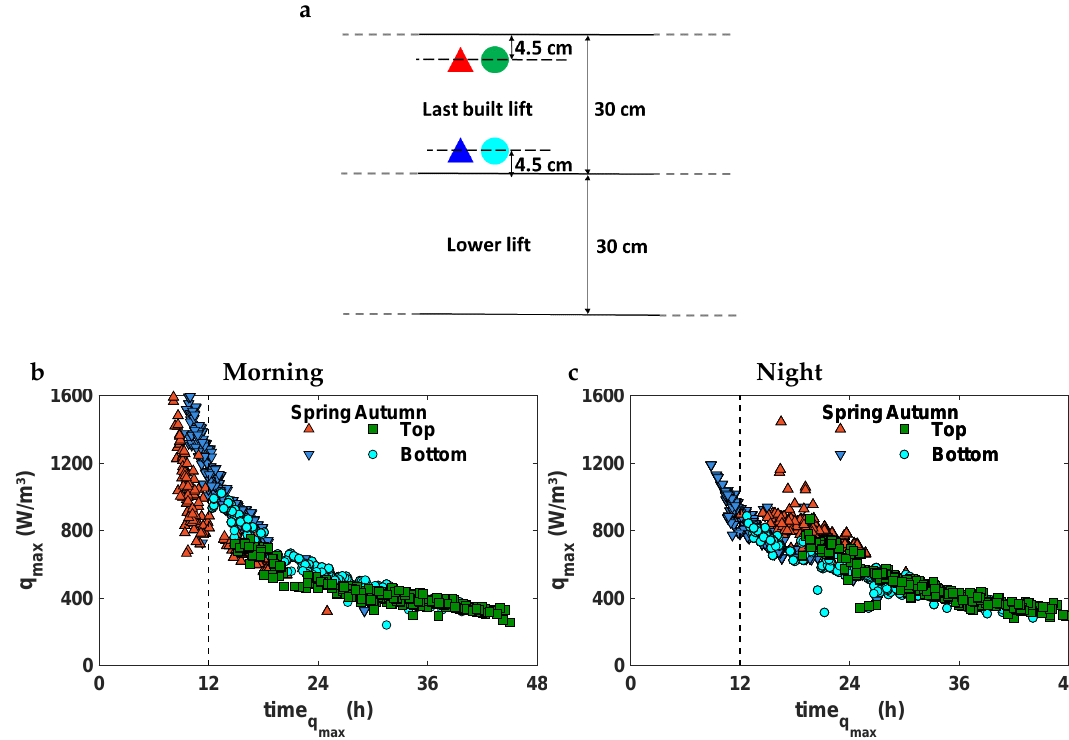
Figure 4. Effect of the weather conditions on the maximum heat generation rate, q max , and timing of q max , t q . We have simulated the construction of two RCC dams whose building started in October, max 2014—autumn—and April, 2014—spring. The hydration reaction is computed with the NAH model. ( a ) Here we depict the schematic position of the analyzed points within the lift. ( b ) We plot q max against t q for all the points within the dam body; i.e., points further than 1 m from the lateral dam faces. max We set lifts at 8 a.m.; i.e., in the morning. The results of the dam built in spring are represented by triangles; red color depicts the point at the top of the lift, and blue the bottom. The results of the dam cast in autumn are plotted with circles; green color represents point at the top of the lift, and cyan the bottom. ( c ) Here we depict q max against time for all points within the dam body and set lifts at 8 p.m.; i.e., at